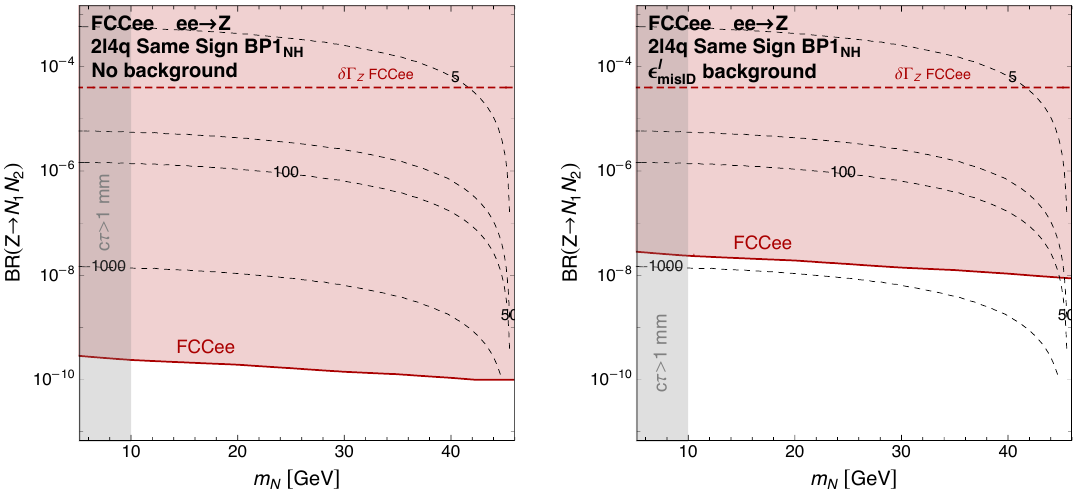
Figure 12 . 95% CL exclusion for BP1 NH from prompt searches in the s-channel Z production channel. The red shaded area represent the exclusion for the case of FCC-ee. Also shown as a red dashed line the limits arising from the measurement of the Z boson total width and as gray dashed lines the isocontours of NP scale Λ in TeV. In the gray shaded area cτ > 1 mm and the RH neutrino cannot decay promptly without being excluded by experimental searches. In the left plot we assume zero background while in the right plot we include the SM reducible background arising from lepton charge mis-identification.